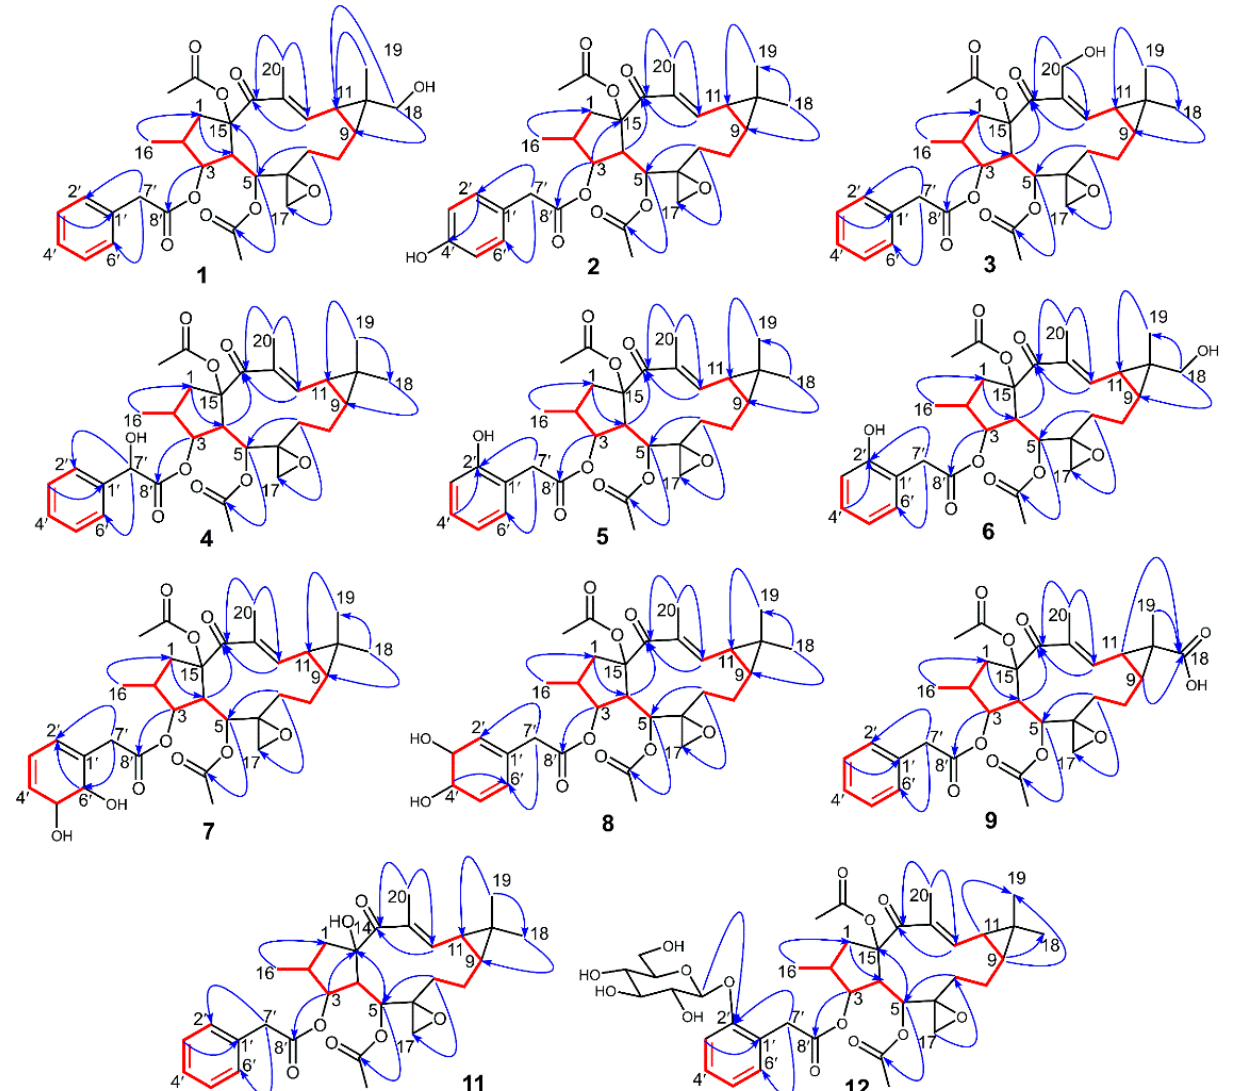
Figure 6. 1 H- 1 H COSY ( ━ ) and HMBC ( → ) correlations of compounds 1 – 9 and 11 – 12 . Figure 6. 1H-1H COSY ( — ) and HMBC ( → ) correlations of compounds 1 – 9 and 11 – 12